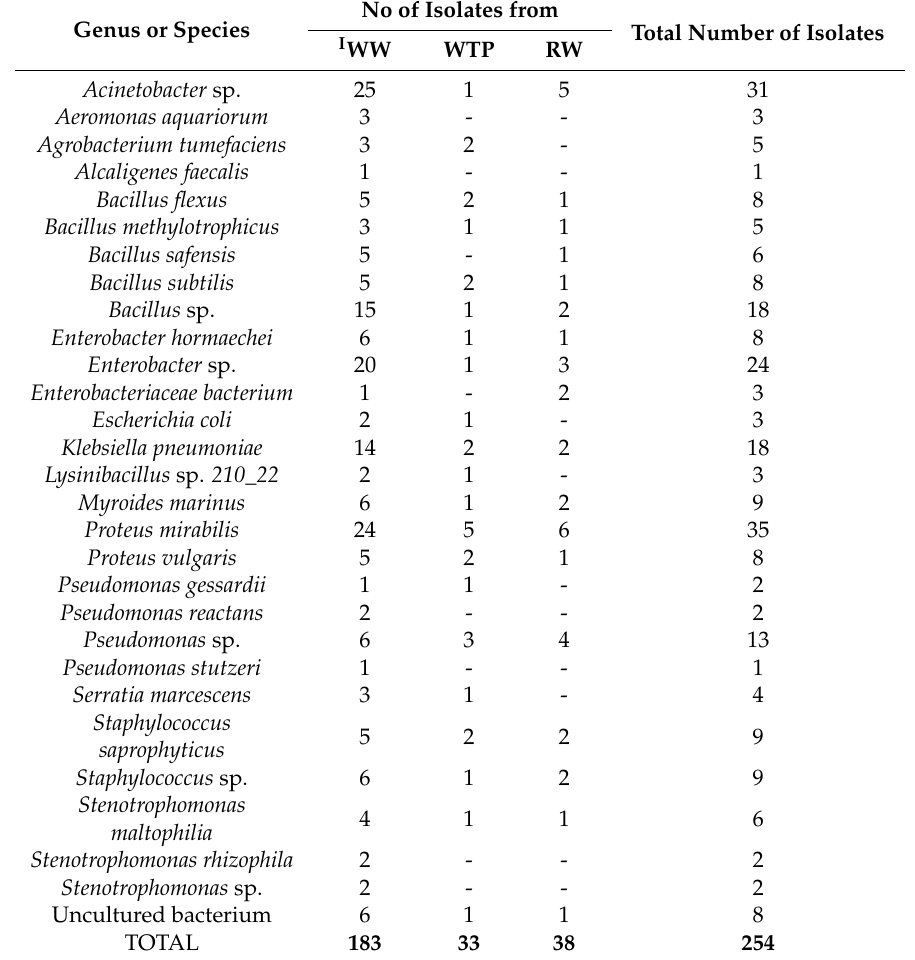
Table 2. Frequency Distribution of Bacterial Strains isolated from wastewater, wastewater treatment plant and river